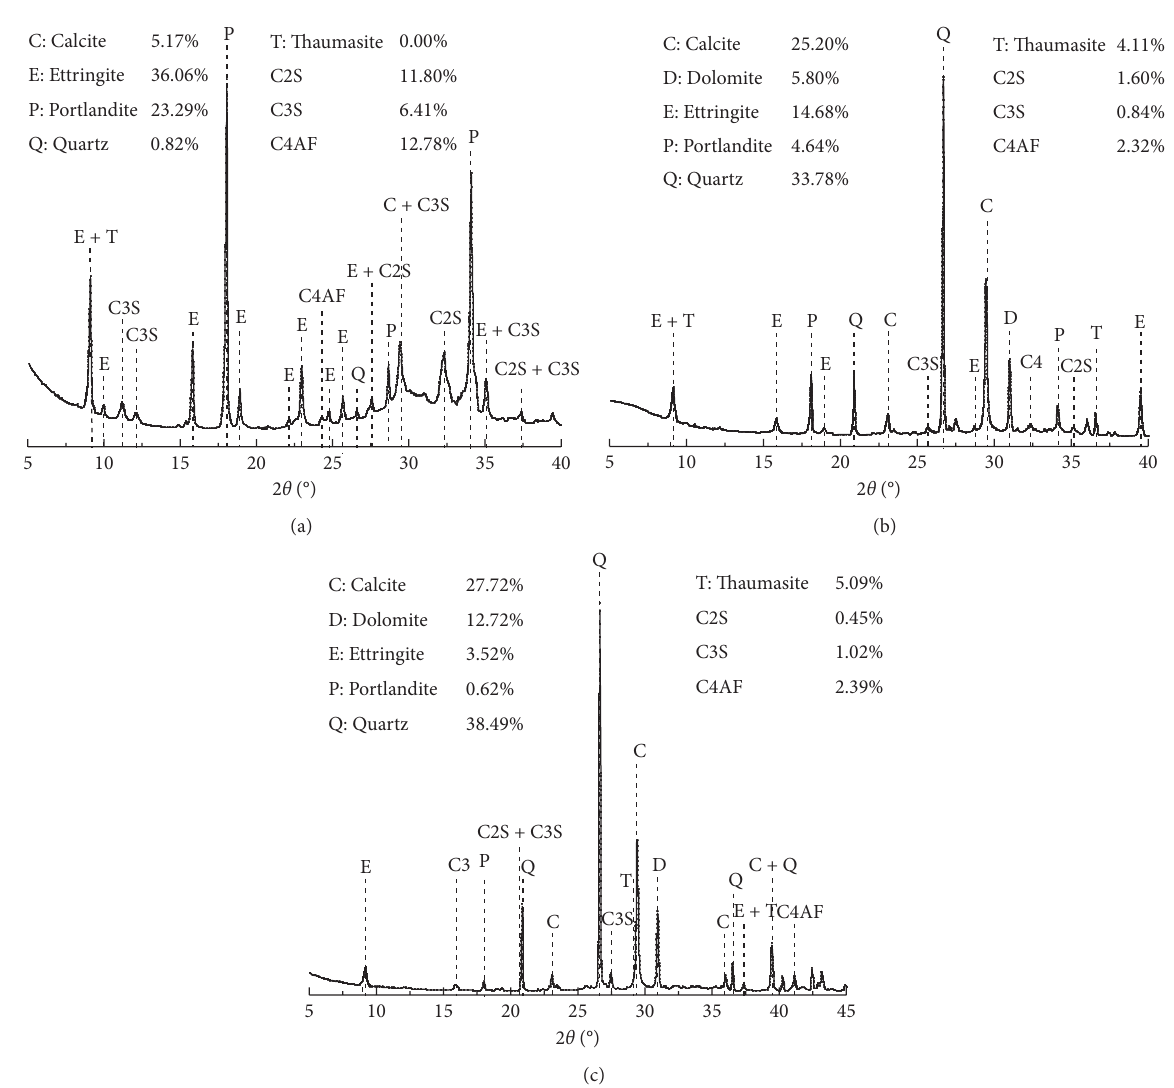
Figure 15: XRD patterns of concrete specimens exposed to sulfate ions in the laboratory. (a) 6 months. (b) 9 months. (c) 11